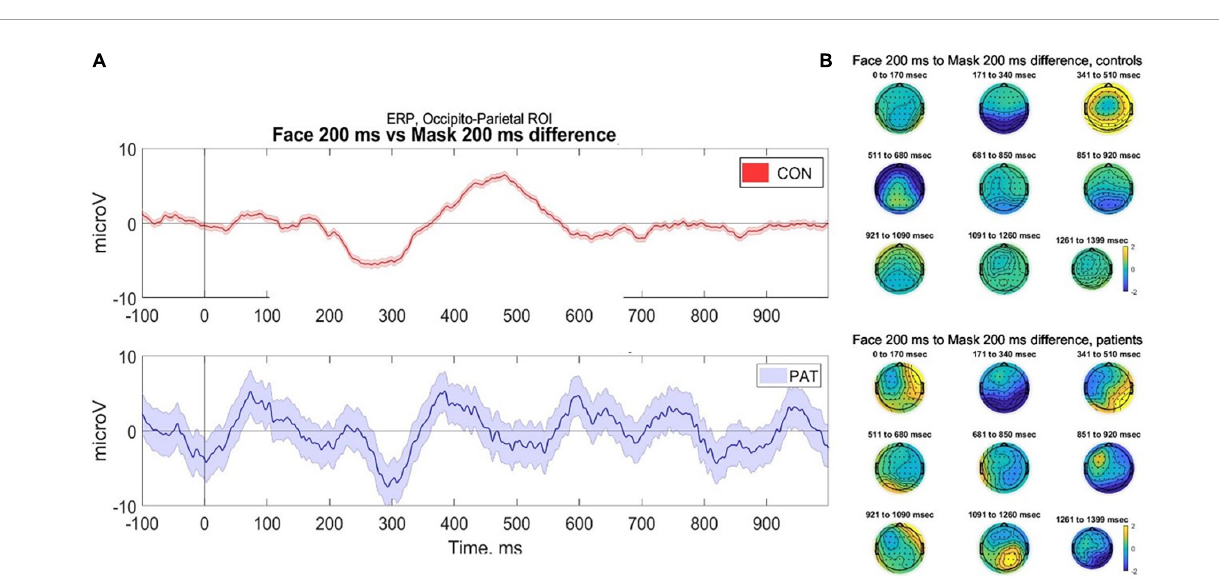
FIGURE3 (A) Averaged voltage across six occipito-parietal electrodes. Controls (top) demonstrate classical components associated with facial perception, namely the visual awareness negativity (VAN) at 200 ms and late positivity (P400) during stimuli where faces were presented at 200 ms, compared to control (masked) trials. In contrast, participants with severe AD (bottom) demonstrate evidence of VAN but reduced late positivity, however due to small numbers the error bars are wide for the patients. (B) 2D scalp topographies of the EEG activity in response to facial perception (trials of face presented for 200 ms). EEG signal is averaged on grand average based time-windows. CONS, controls; PAT, people with severe